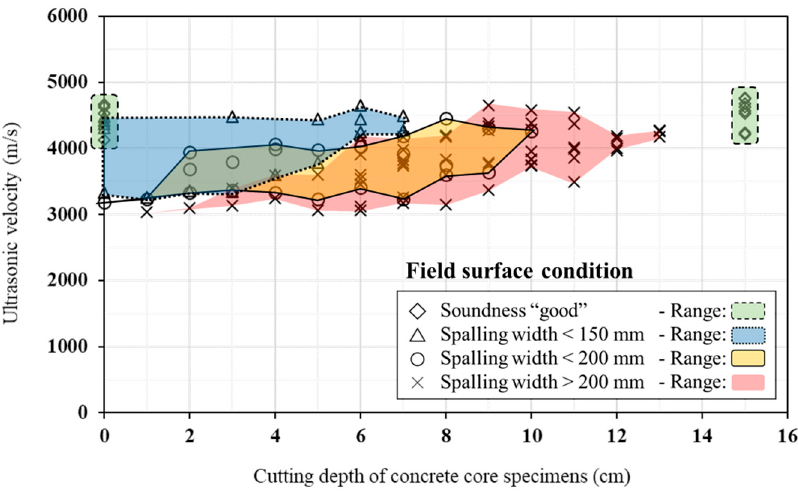
Figure 8. Ultrasonic velocity test for the cutting depth of core specimens.